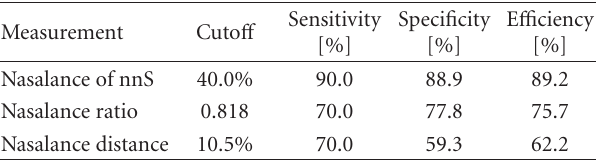
Table 5: Validation data for di ff erentiation between patients with marked and severe hypernasality.